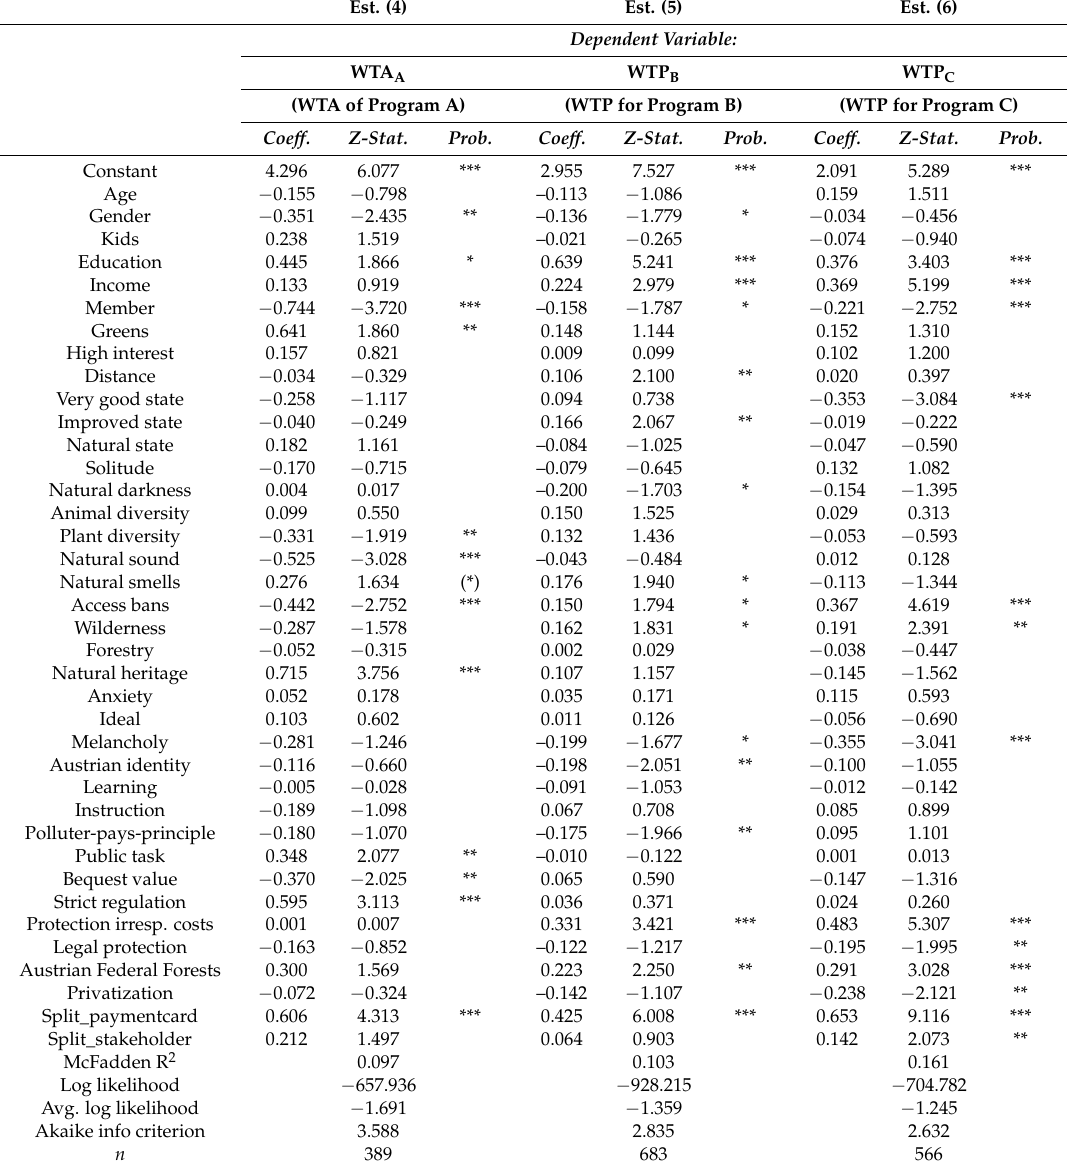
Table 5. Determinants of the respondents’ willingness to accept/willingness to pay with regard to scenarios of forest and biodiversity development (computation by a standard maximum likelihood Tobit model, extreme value; *** p < 0.01, ** p < 0.05, * p <